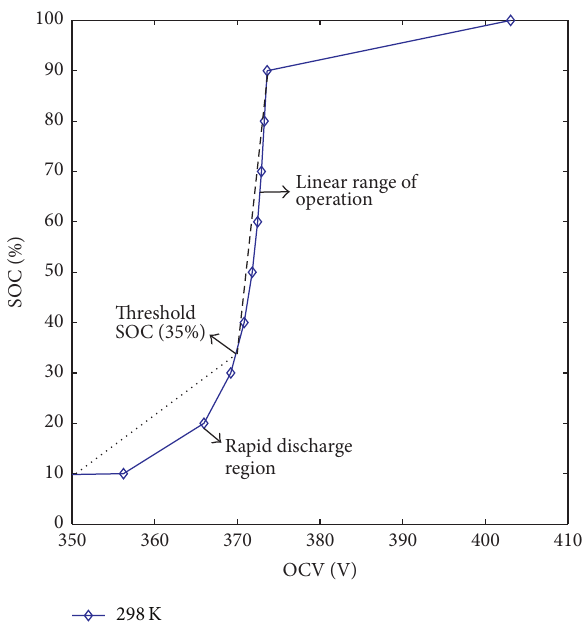
Figure 9: Determination of threshold